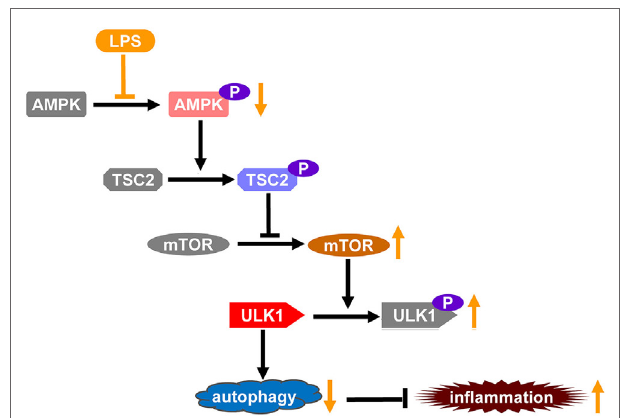
FigUre 6 | The schematic diagram of the mechanisms through which lipopolysaccharide (LPS)-induced dephosphorylation of AMP-activated protein kinase (AMPK) potentiates inflammatory injury. Autophagy plays crucial roles in the limitation of inflammation, which is a tightly organized process. ULK1 is a key factor promoting the initiation of autophagy, it could be phorphorylated and inhibited by mammalian target of rapamycin (mTOR), a primary negative regulator of autophagy. AMPK functions as a suppressor of mTOR, it suppressed the activation of mTOR via phosphorylating TSC2, an inhibitor of mTOR, and thus prevents the inhibitory phosphorylation of ULK1 and promotes the induction of autophagy. LPS exposure induces the dephosphorylation and suppression of AMPK, which might result in weakened inhibition of mTOR, increased inhibitory phosphorylation of ULK1, and repressed autophagy. Thus, LPS-induced dephosphorylation of AMPK and repression of autophagy might be a novel mechanism underlying the development of inflammatory